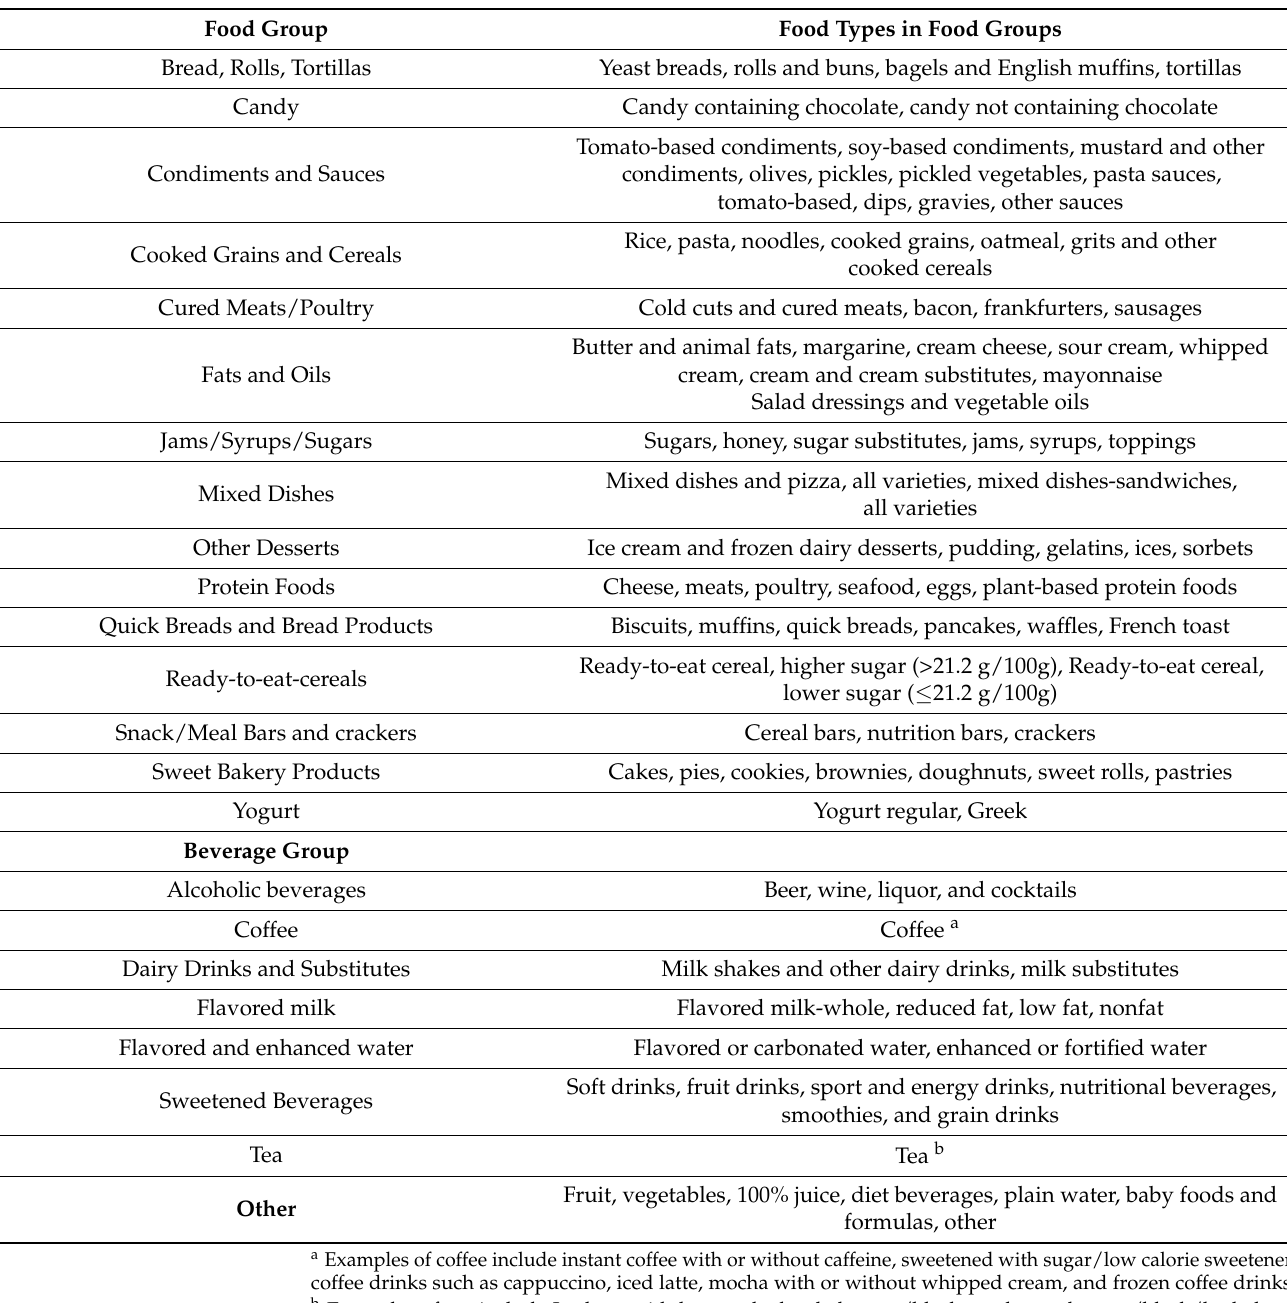
Table A1. Breakdown of food groups that contribute to intake of added sugars determined by What We Eat in America